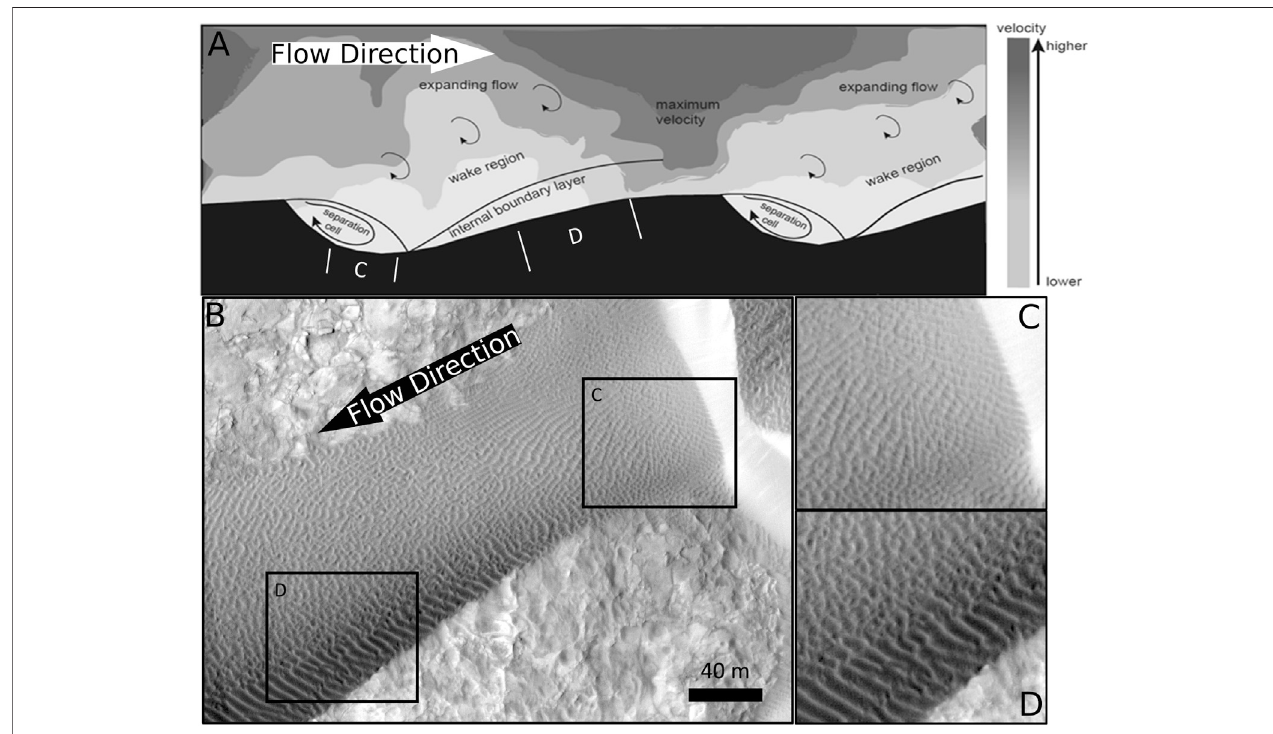
FIGURE 1 | Models of fl ow over dunes (A) with ripple patterns that may be connected to different regimes of fl ow (B – D) . The ripple pattern in (C) typi fi es the patterns seen in dune wakes: subdued, near isotropic patterns with evidence for primary ripple development with crests extending from the base of the slipface and superposed secondary ripple development parallel tothe slipface. The patterns in (D) typify dune-top ripples (upper left) and 2-D rippleson a dune fl ank (lower right) .